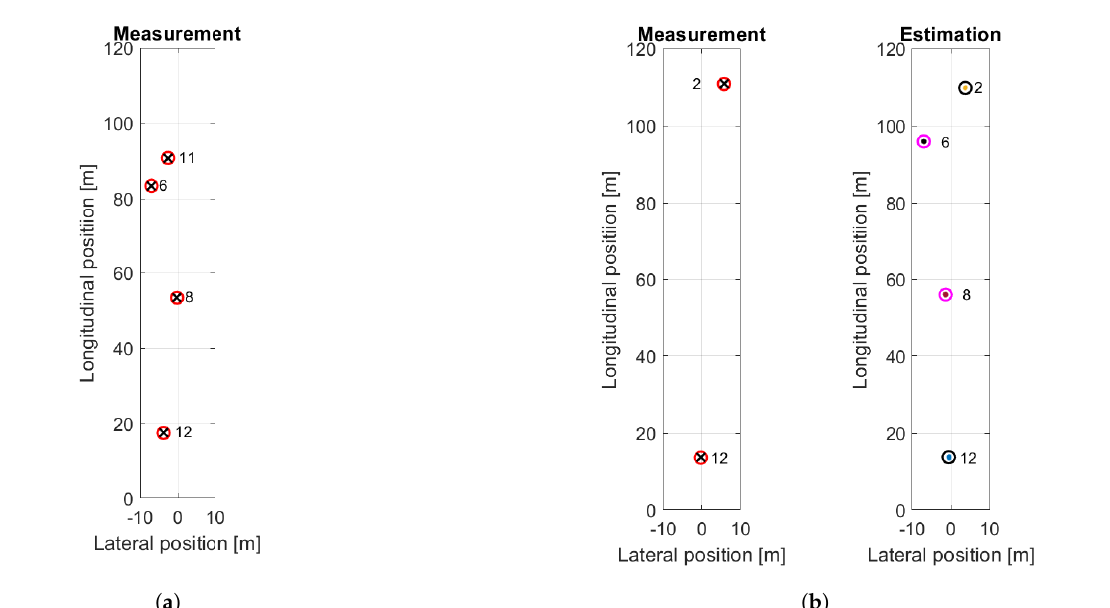
Figure 15. Vehicle positions at the beginning ( a ) and during lane-changing maneuver ( b ), when vehicle 12 occludes vehicle 6 and